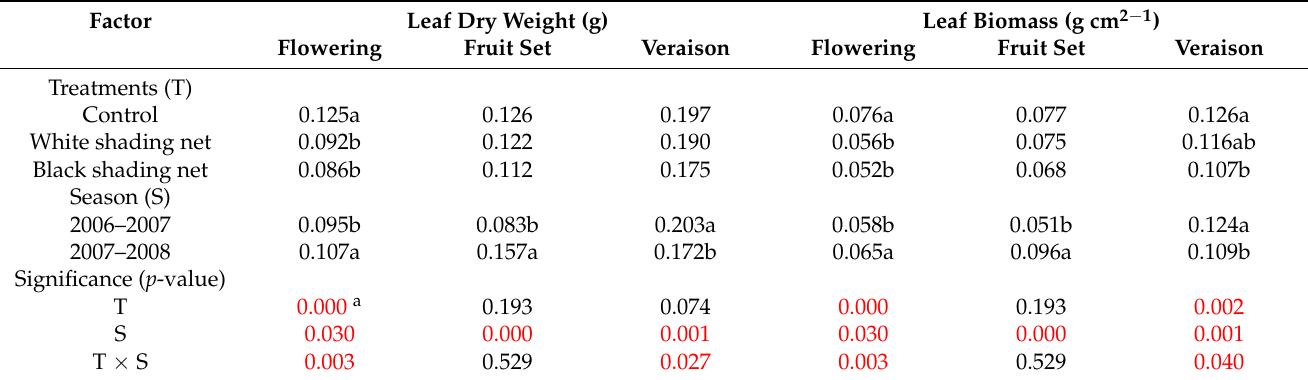
Table 5. Analysis of leaf dry weight and leaf biomass during flowering, fruit set and veraison affected by shading net treatments and control in 2006–07 and 2007–08